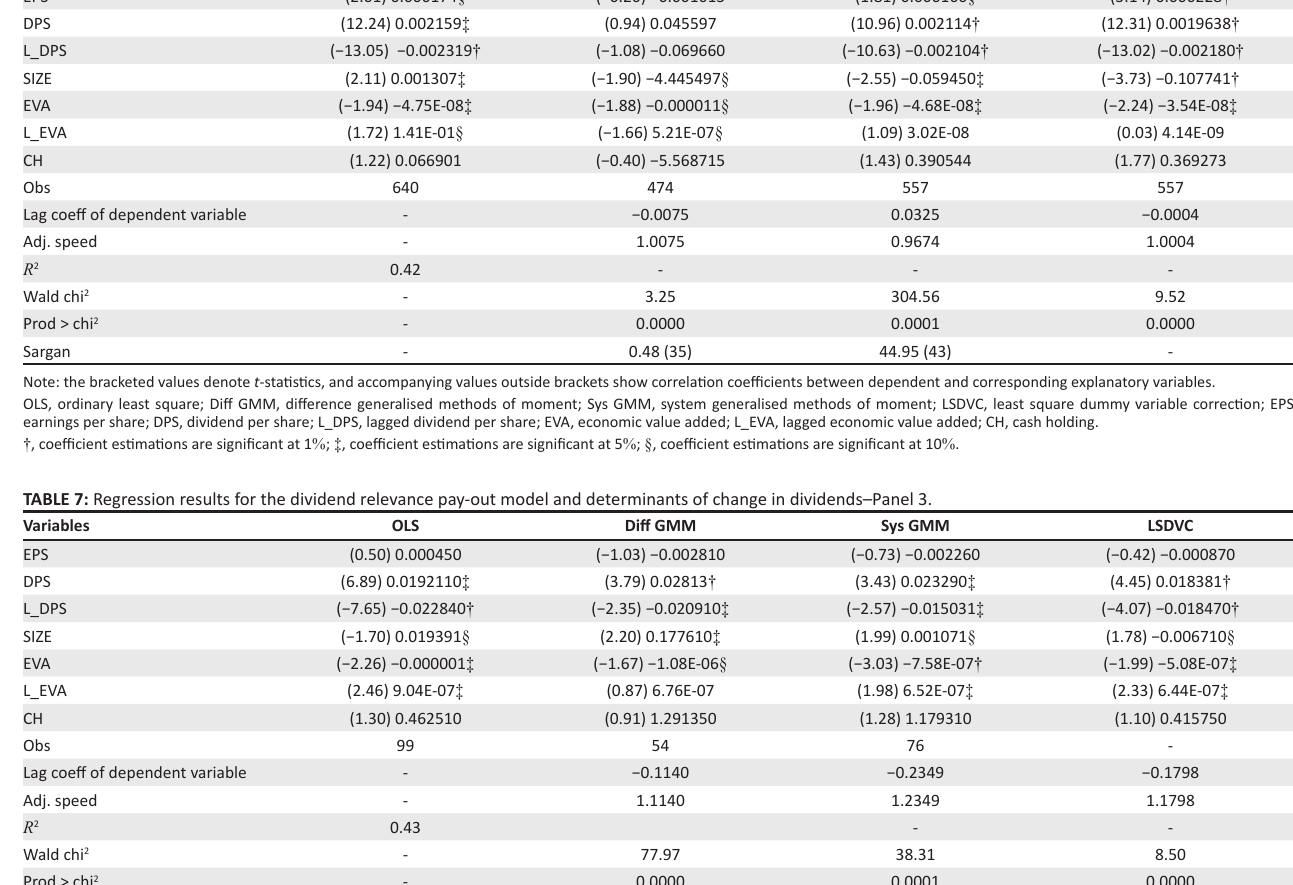
TABLE 6: Regression results for the dividend relevance pay-out model and determinants of change in dividends–Panel 2.